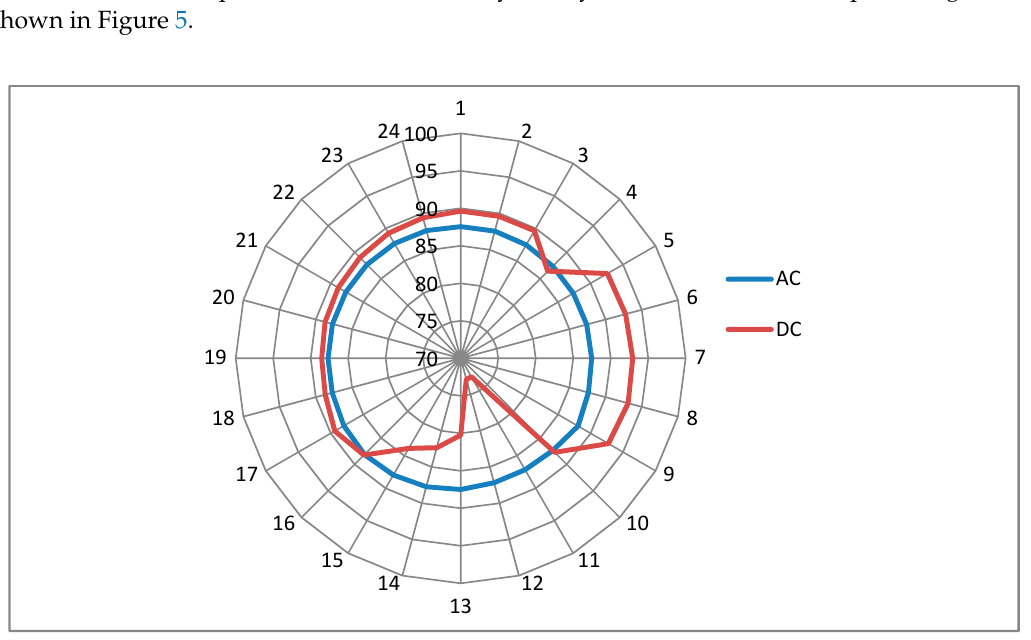
Figure 5. AC-DC system efficiency with the inclusion of 1-kW solar PV panels.